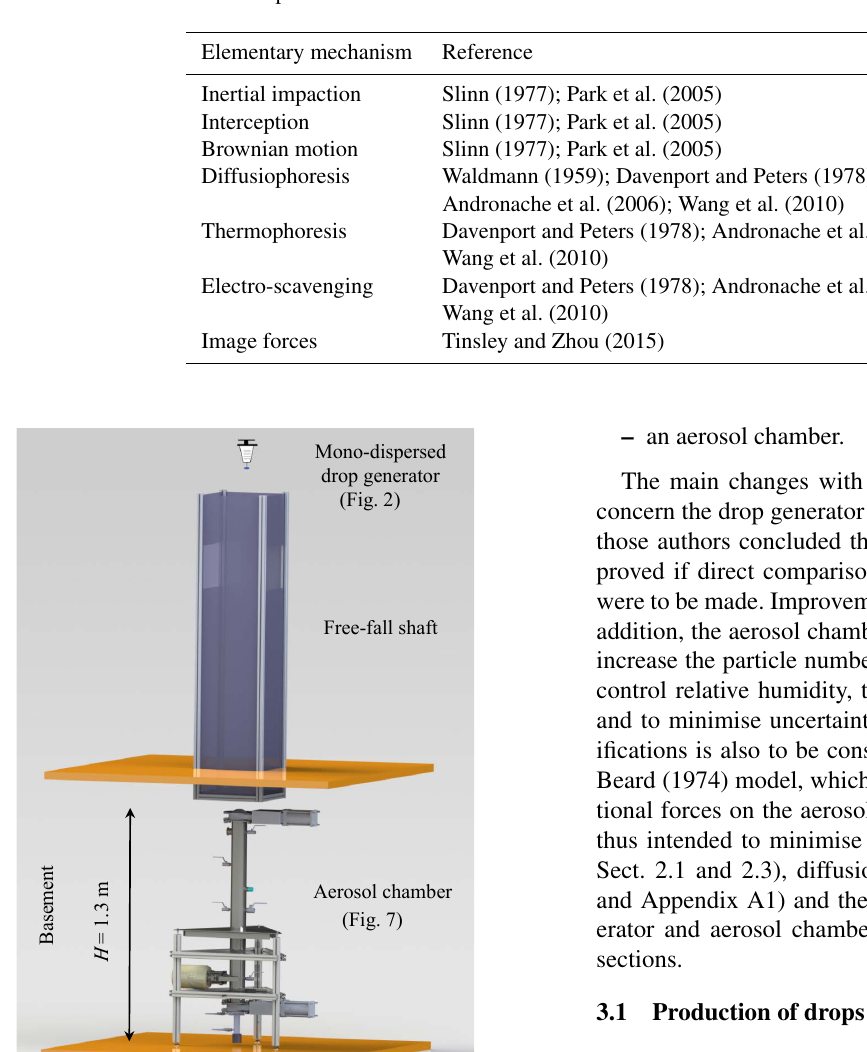
Table 1. References of theoretical expressions for the calculation of each collection mechanism.